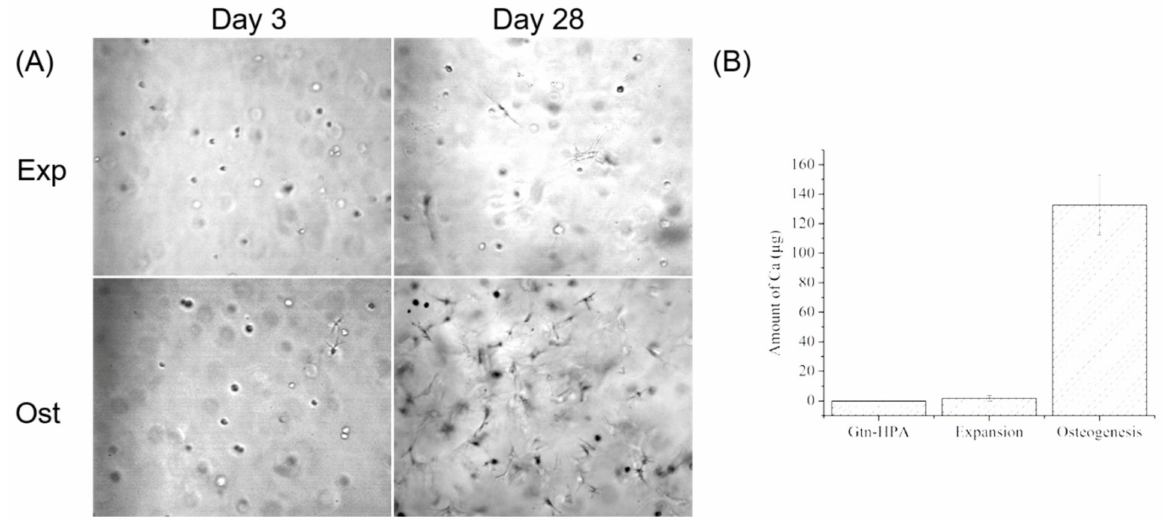
Figure 8. bMSC osteogenic differentiation and calcium deposition in 2% Gtn-HPA gels. ( A ) Morphology of cells in expansion medium and osteogenic medium on day 3 and day 28; ( B ) Amount of Ca mineralized by the cells in Gtn-HPA gels, quantified by